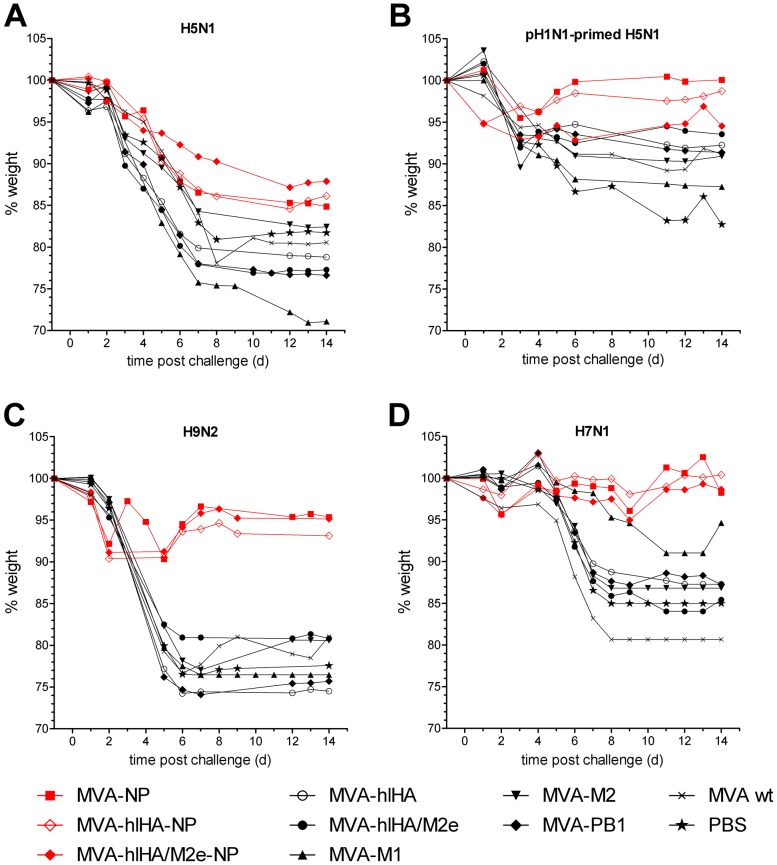
Weight loss after H5N1, H9N2 and H7N1 challenge.Mice were immunized twice, three weeks apart, with MVA vectors and challenged three weeks later with (A and B) 42 LD50 of H5N1 VN1203, (C) 32 LD50 of mouse-adapted H9N2 HK/G9 or (D) 16 LD50 of H7N1 RO/34. (B) Primed mice were infected intranasally with 100 TCID50 H1N1pdm09 virus, six weeks before immunization. Animals were monitored for 14 days after challenge. Shown are the daily variations in weight, as percentages compared to before virus challenge.